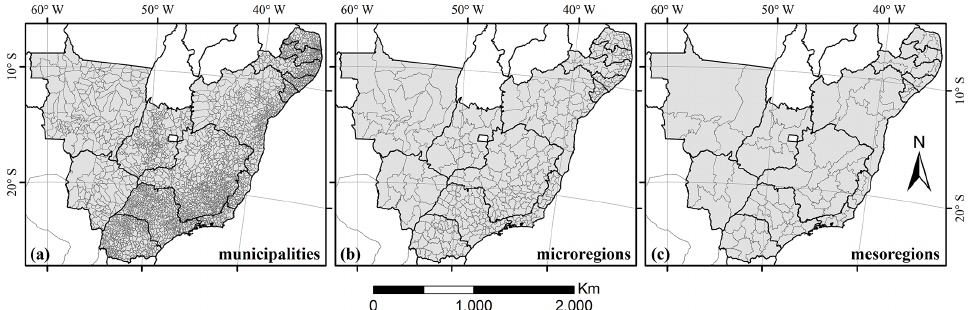
Figure 4. The administrative boundaries for (a) municipalities, (b) microregions, and (c) mesoregions. The boundary lines at the municipality and state levels were downloaded directly from the IBGE, and we aggregated the municipalities into microregions and mesoregions according to the regions in PAM denoted by the